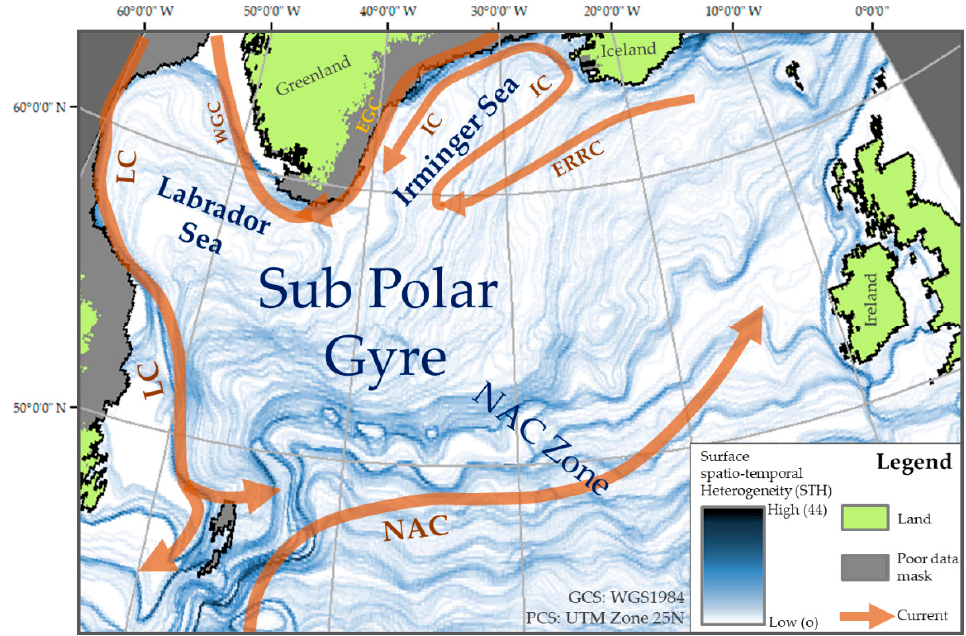
Figure 10. 2011 surface spatio-temporal heterogeneity (STH) in relation to a selection of simplified regional features of the North Atlantic. The STH dataset produced by the OHMA process is shown, overlaid by the approximate locations of the Subpolar Gyre and main bounding near-surface currents, including the North Atlantic current (NAC), East Reykjanes Ridge current (ERRC), Irminger Current (IC), East Greenland Current (EGC), West Greenland Current (WGC), and the Labrador Current (LC). Feature locations were derived using information from [59–62].